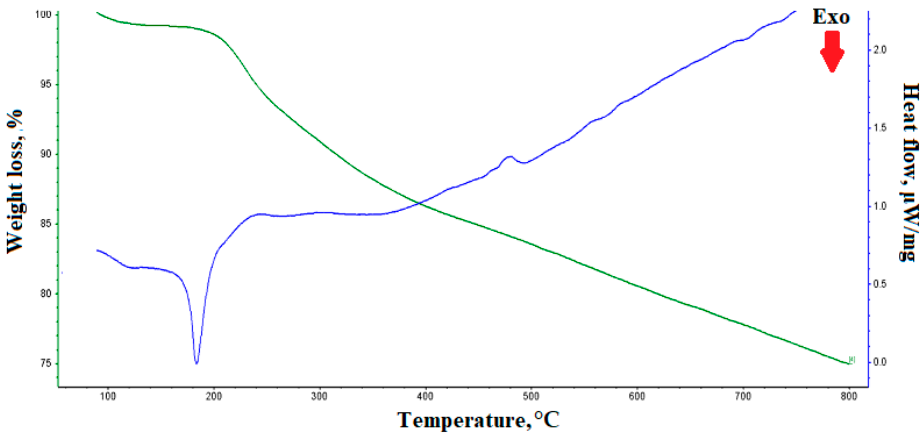
Figure 9. TGA and DSC of polymethylene blue.